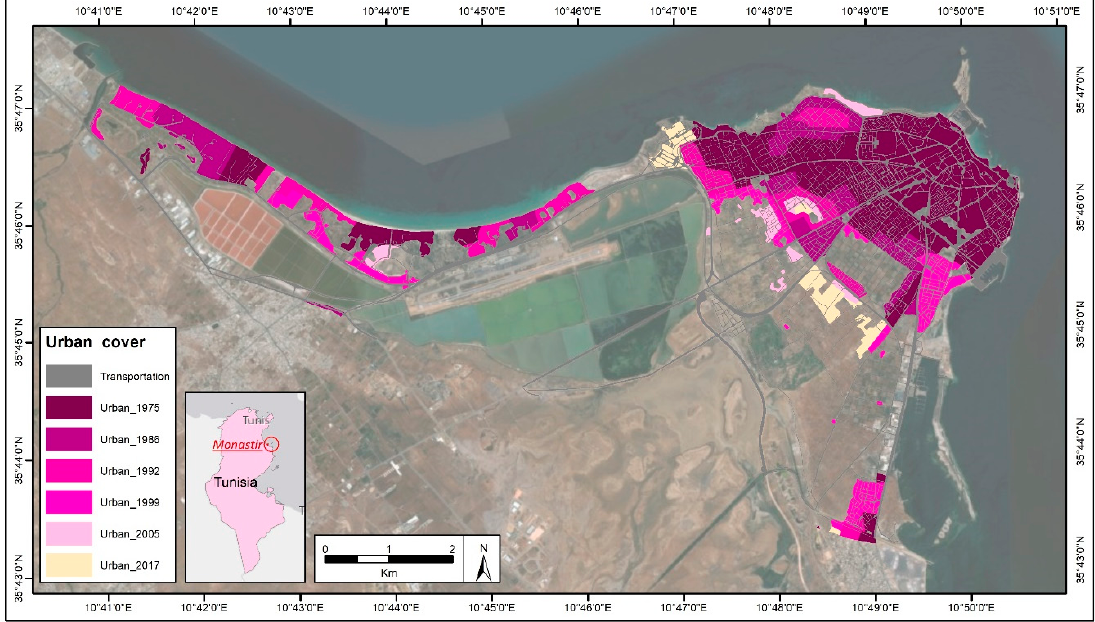
Figure 3. Urban development from 1975 to 2017 based on multi-temporal remote sensing data.